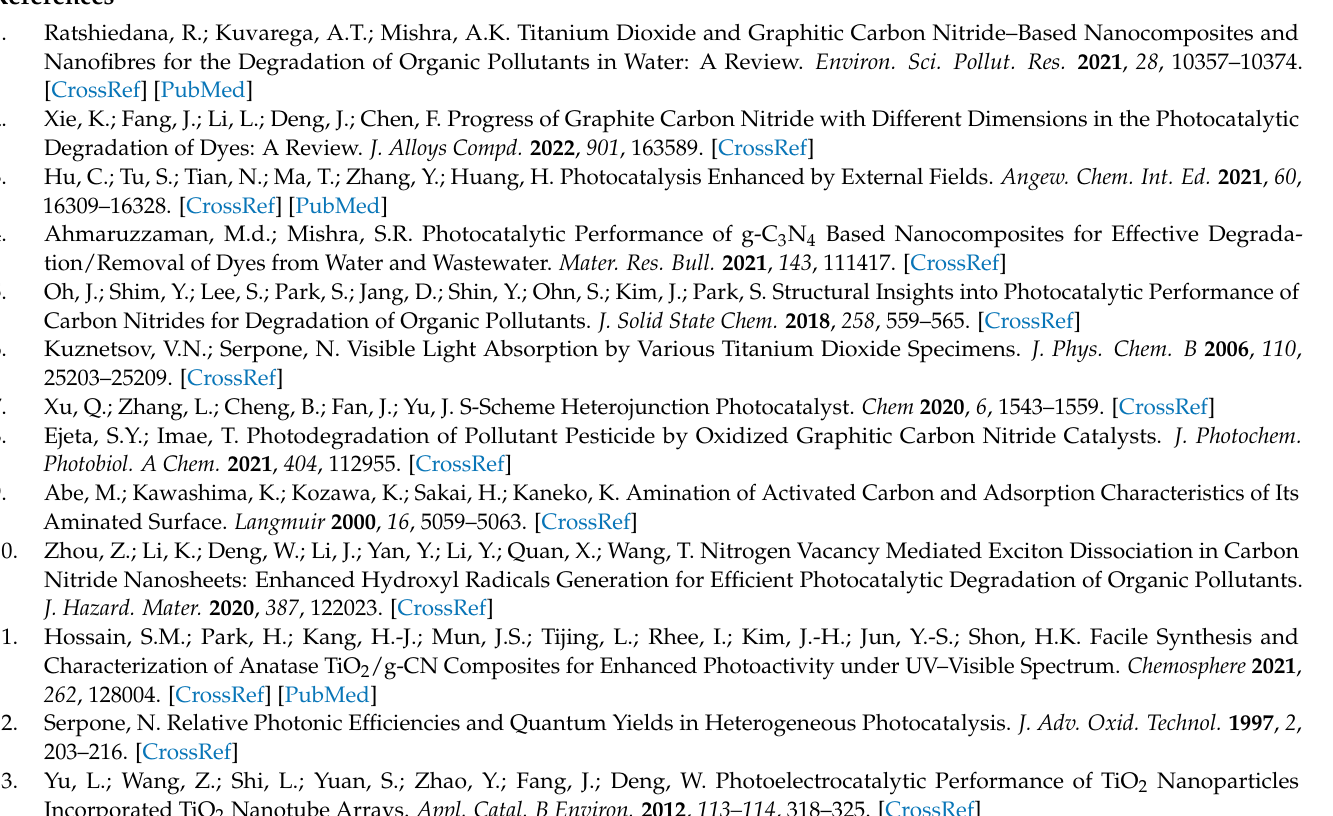
B-C 3 N 4 , TiO 2 /C 3 N 4 , B2-C 3 N 4 /TiO 2 and B-TiO 2 /C 3 N 4 , Figure S2: MB removal efficiency of B- TiO 2 /C 3 N 4 prepared with different doping amount, Figure S3: N 2 adsorption-desorption curves of B-TiO 2 /C 3 N 4 materials at different temperatures, Figure S4: XRD (X-ray diffraction) patterns of B 2 O 3 and B-TiO 2 /C 3 N 4 -2 Series materials, Figure S5: FT-IR spectra for different temperature B-TiO 2 /C 3 N 4 , Figure S6: XPS spectra of B-TiO 2 /C 3 N 4 material (a)B1s, (b)C1s, (c) N1s, (d) Ti2p and (e) O1s, Figure S7. The Diffuse reflectance spectra for different temperature B-TiO 2 /C 3 N 4 , Figure S8. Synthesis path of B-TiO 2 /C 3 N 4 material, Figure S9. Changes of TOC in the experiment of adsorption-catalytic degradation of pollutants (a) MB (b) RhB. References [45–47] are cited in the supplementary